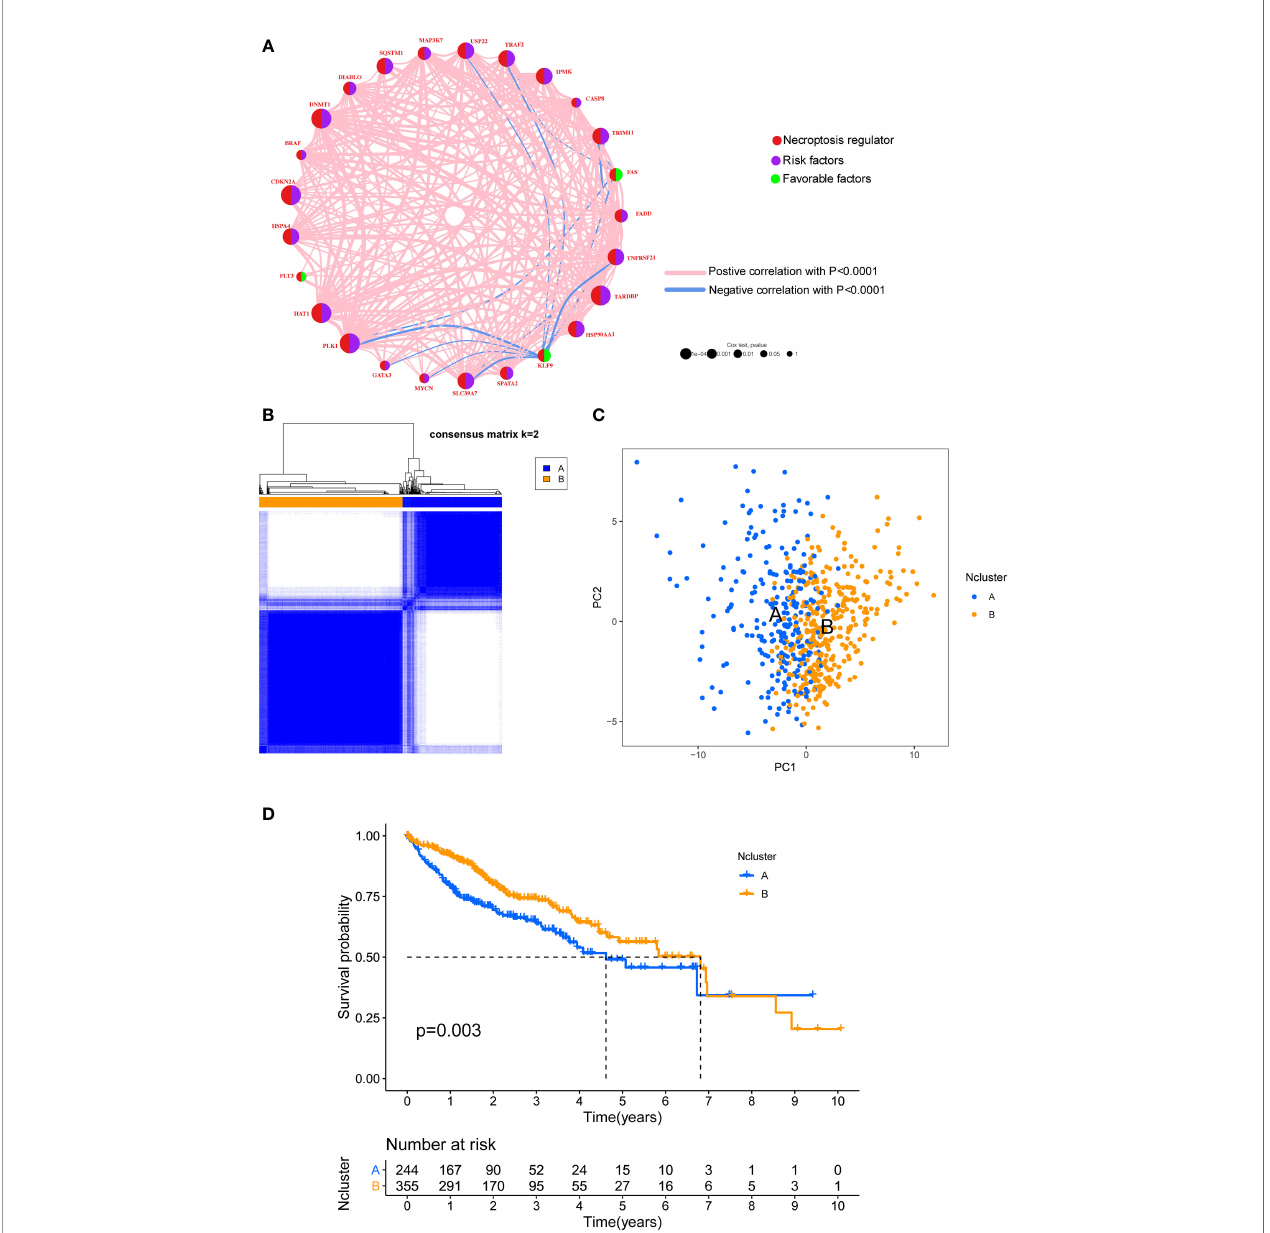
FIGURE 2 | Unsupervised clustering of necroptosis regulators. (A) Interaction network of necroptosis regulators in HCC. Necroptosis regulators were indicated by red circles. Risk factors were indicated by purple circles, and favorable factors were indicated by green circles. Different sizes of the circle represented the different P- values. Red lines showed the positive correlation, and blue lines showed the negative correlation. (B) Consensus clustering matrix for k =2. (C) The feature distribution between different two Nclusters was plotted via PCA. (D) Kaplan-Meier curves of the OS for the two Nclusters of HCC patients. Ncluster, necroptosis cluster; PCA, principal component analysis; OS, overall survival; HCC, hepatocellular